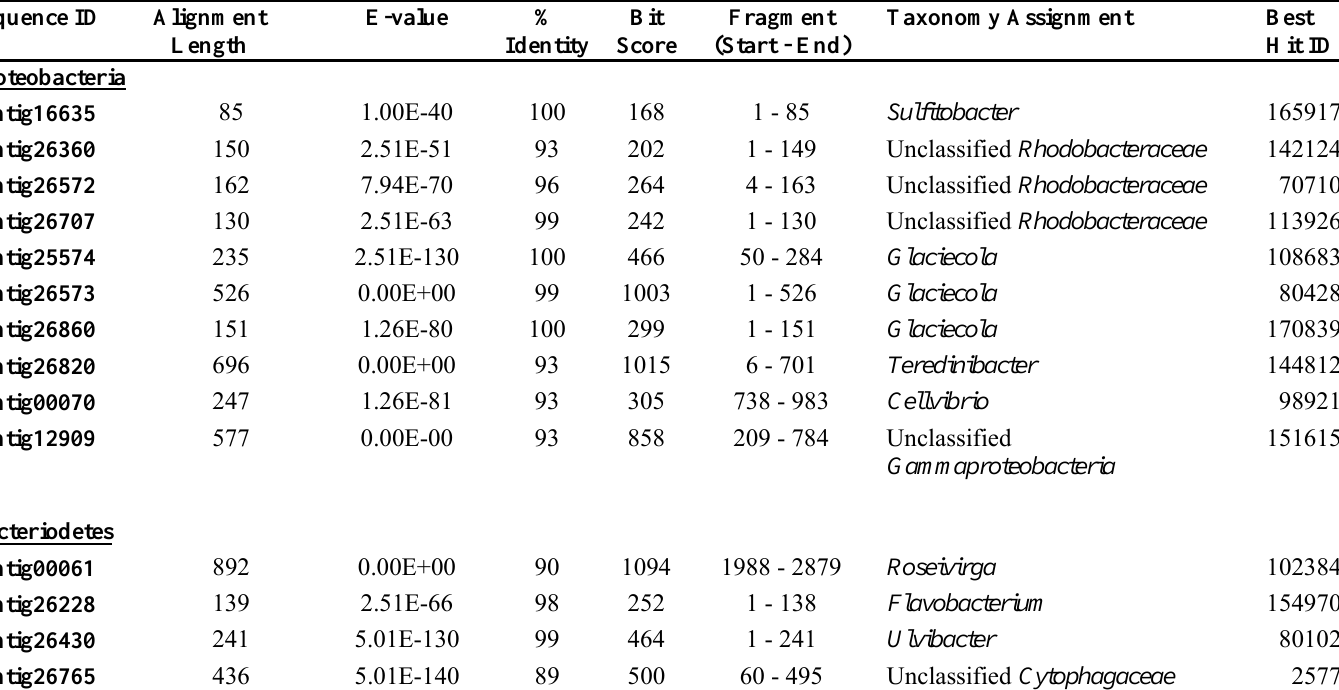
Table 1. Identification of 16S rRNA genes in the Irish Sea cellulose biofilm DNA 454 pyrosequenced dataset by the Greengenes 16S rRNA gene